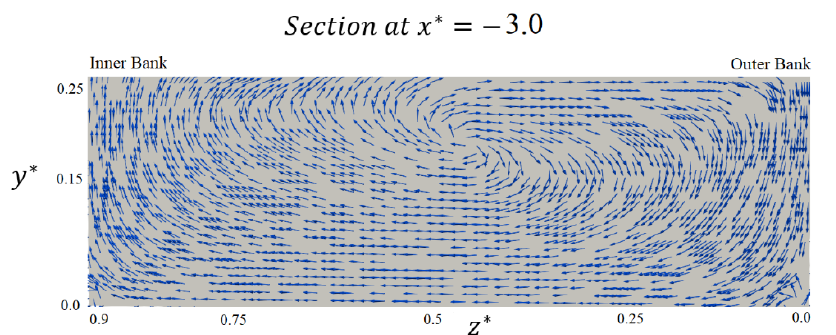
Figure 19. The vectors of velocity at section x* = − 3.0 (Standard k- ε ).